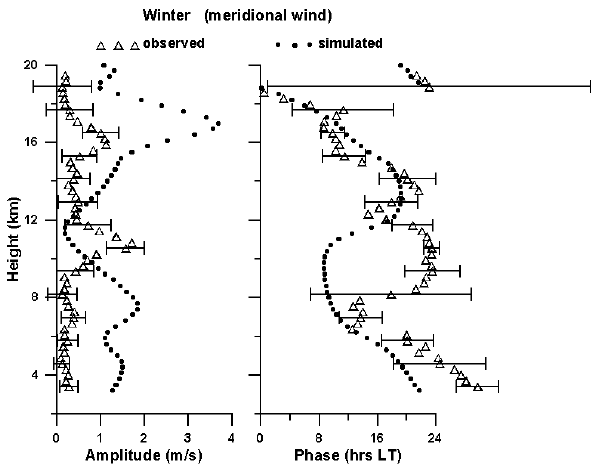
Fig. 4. Same as Fig. 2, but for the winter season.